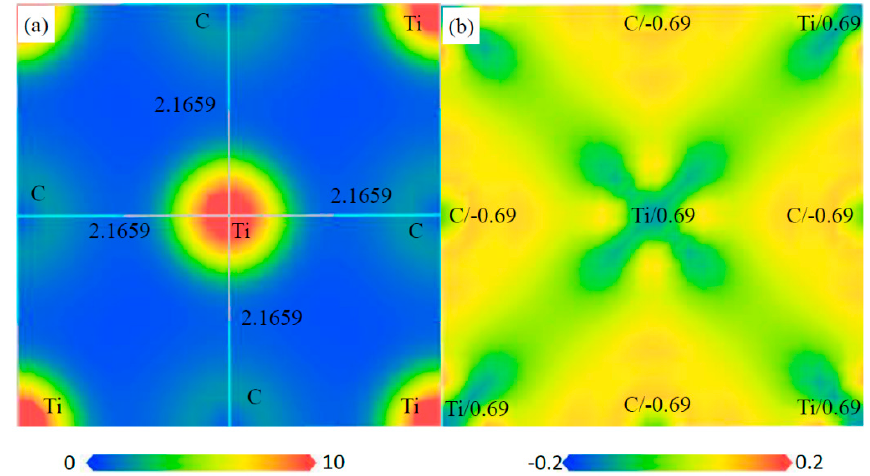
Figure 13. Electron density maps of the (0 0 1) plane in Ti 4 C 4 , ( a ) total electron density map from 0 to 10 (e/Å 3 ) and the bond length (Å), ( b ) electron density difference map (e/Å 3 ) and the atomic populations (e).